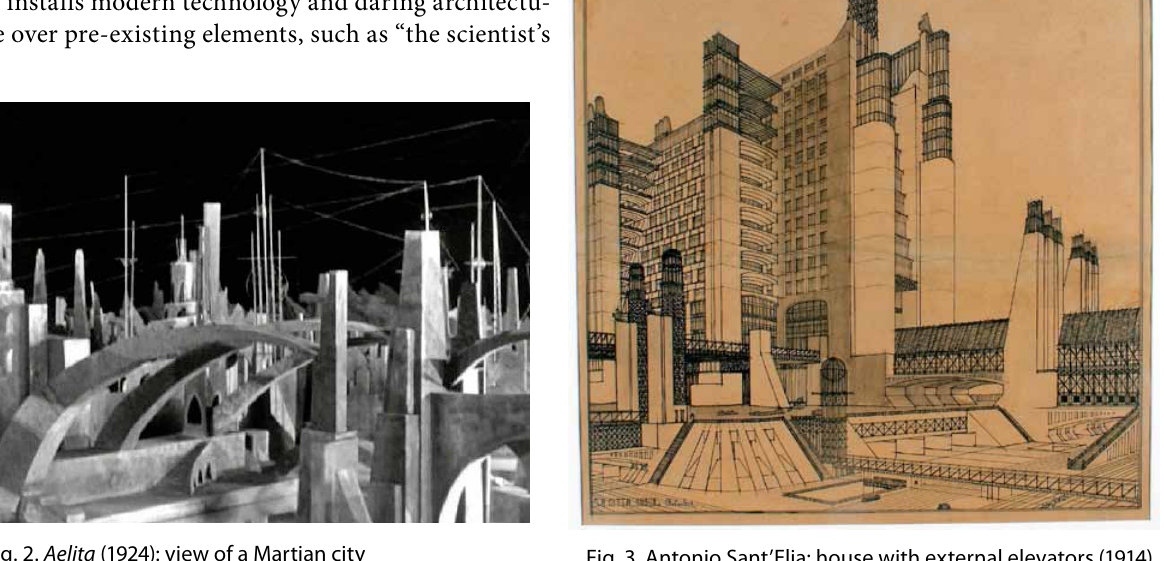
fig. 2. Aelita (1924): view of a Martian city fig. 3. antonio Sant’Elia: house with external elevators (1914)